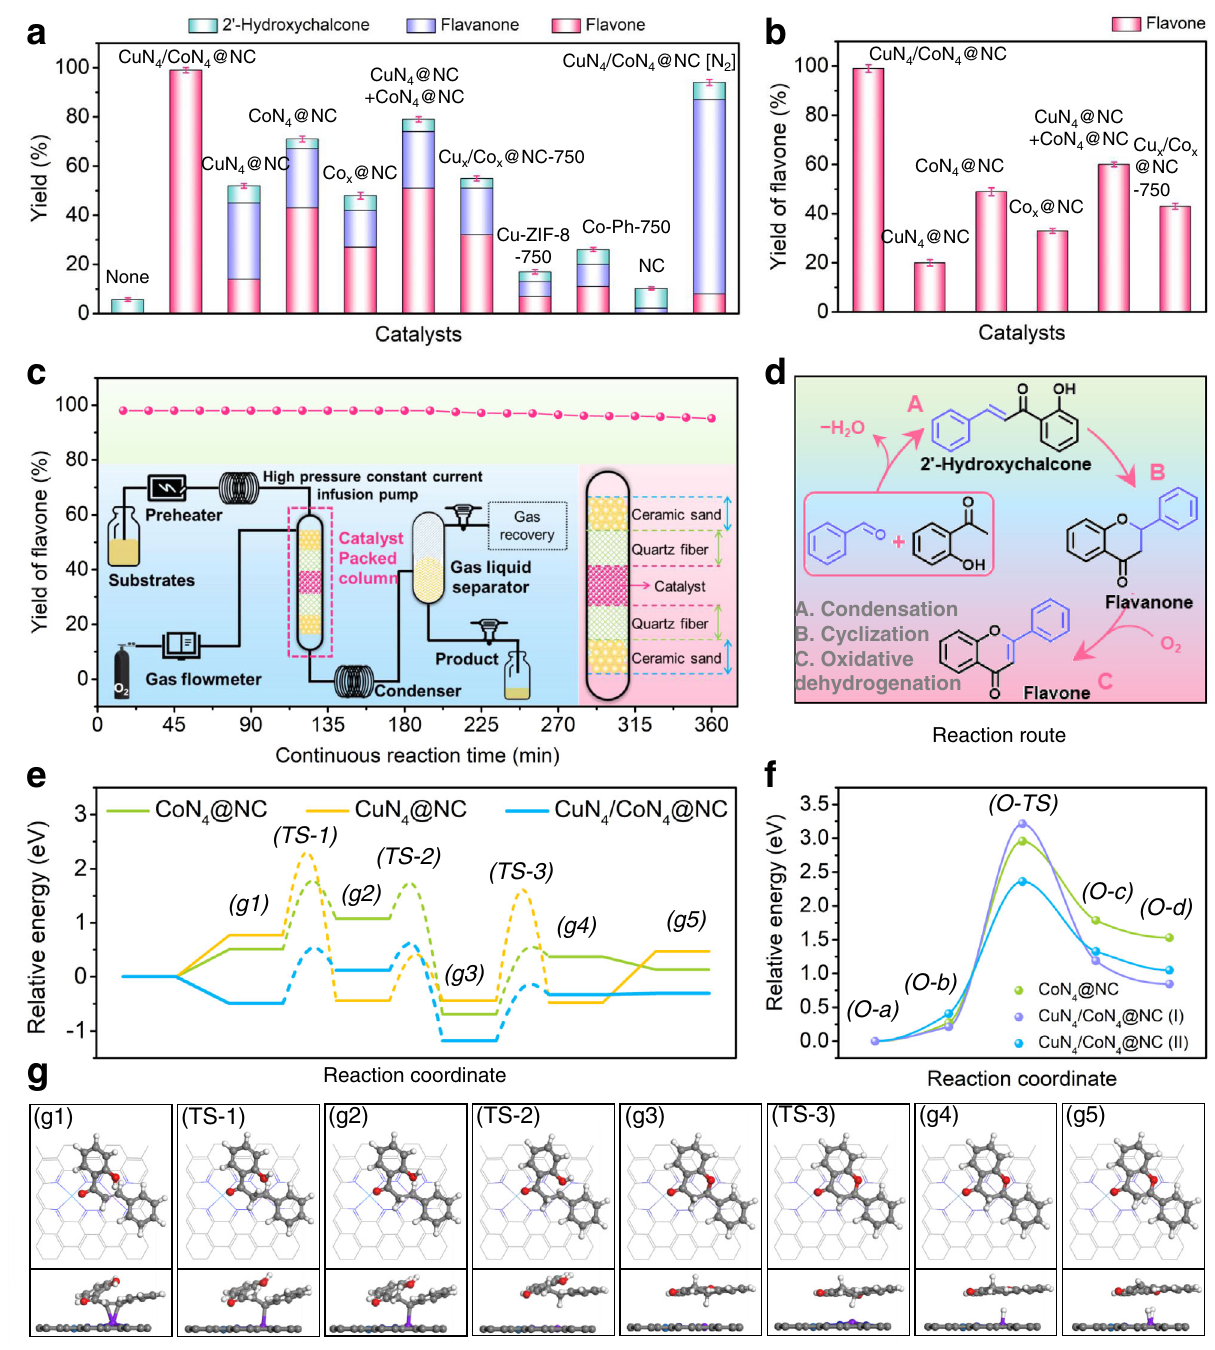
g atomistic structures of the initial state, transition state, and fi nal state for the reaction pathways from 2'-hydroxychalcone to fl avone on CuN 4 /CoN 4 @NC. The grey, blue, sky blue, purple, red, and white balls represent C, N, Cu, Co, O, and H atoms, respectively. “ TS ” denotes a transition state. f CI-NEB results of O 2 dis- association. The error bars represent standard deviation based on three